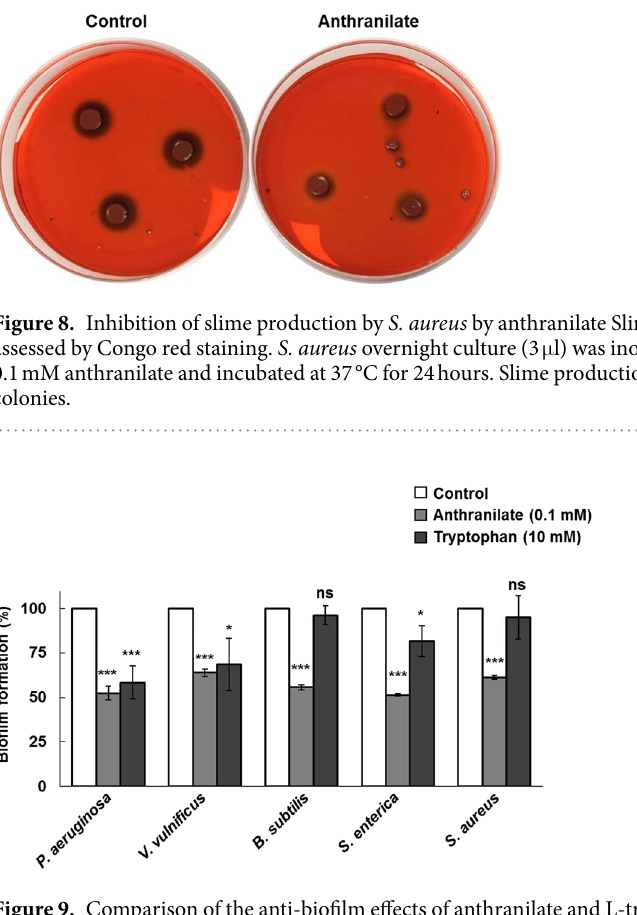
Figure 9. Comparison of the anti-biofilm effects of anthranilate and L-tryptophan The anti-biofilm effects of L-tryptophan (10 mM) and anthranilate (0.1 mM) were compared by static biofilm analysis. Results are presented as percentages of controls. * p < 0.05; *** p < 0.005; ns, no significant difference ( p >